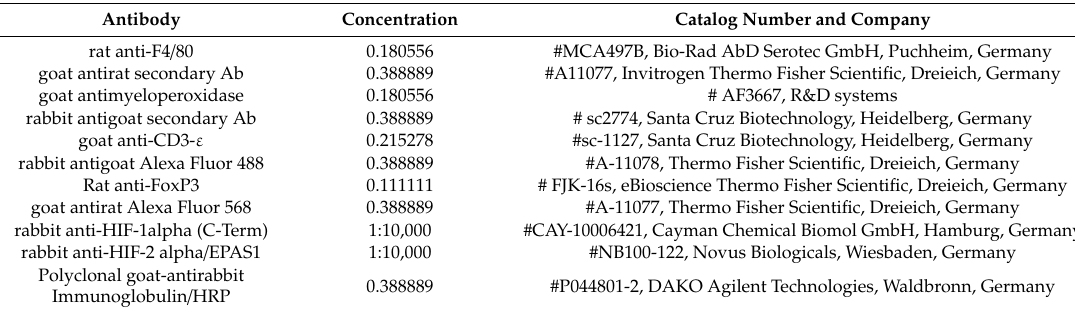
Table 3. Antibodies in immunohistochemistry